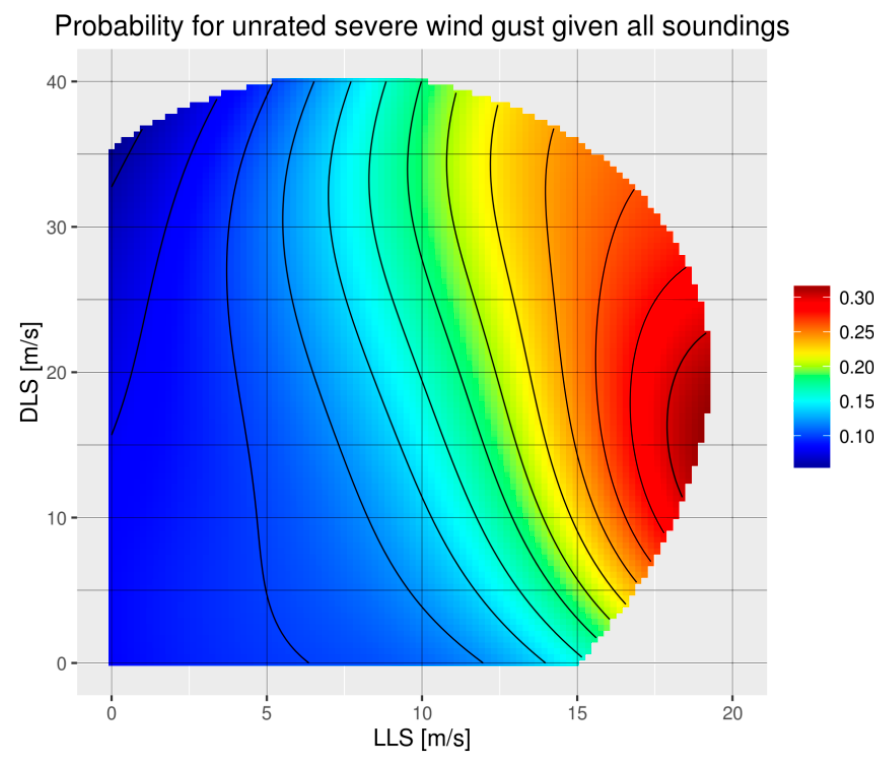
Figure 11. As in Figure 9, except for the unrated severe wind.